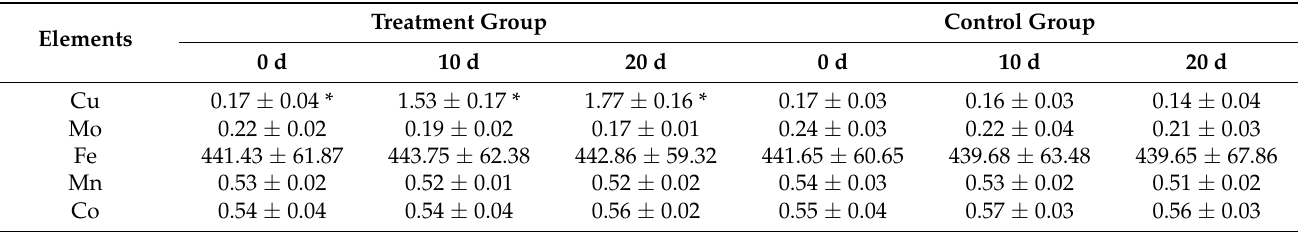
Table 6. The mineral element level in animal blood ( µ